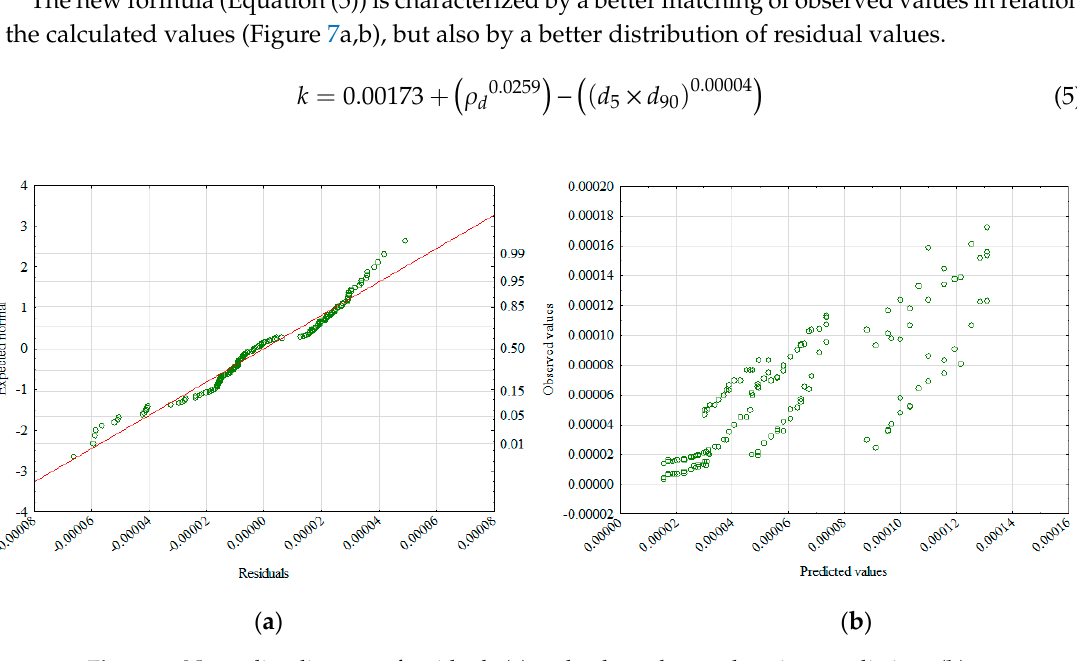
Table 4. Evaluation of fixed parameters for model 2.